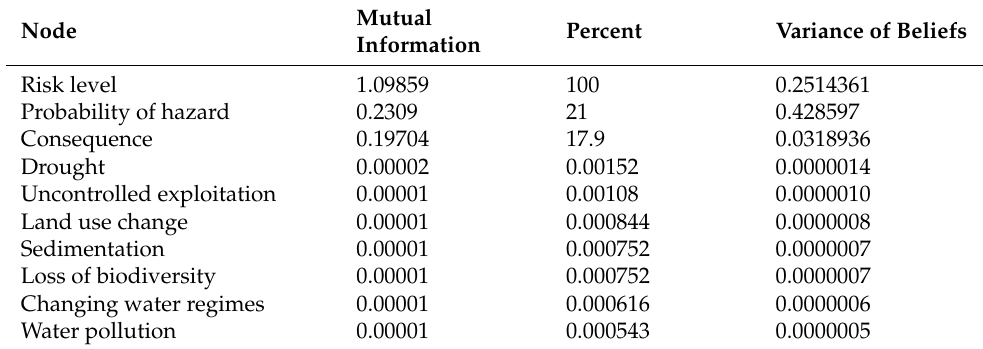
Figure 8. Diagnostic model in sensitivity analysis of SIWs. Table 2. Sensitivity analysis results of the BBN model for environmental risk levels of SIWs.